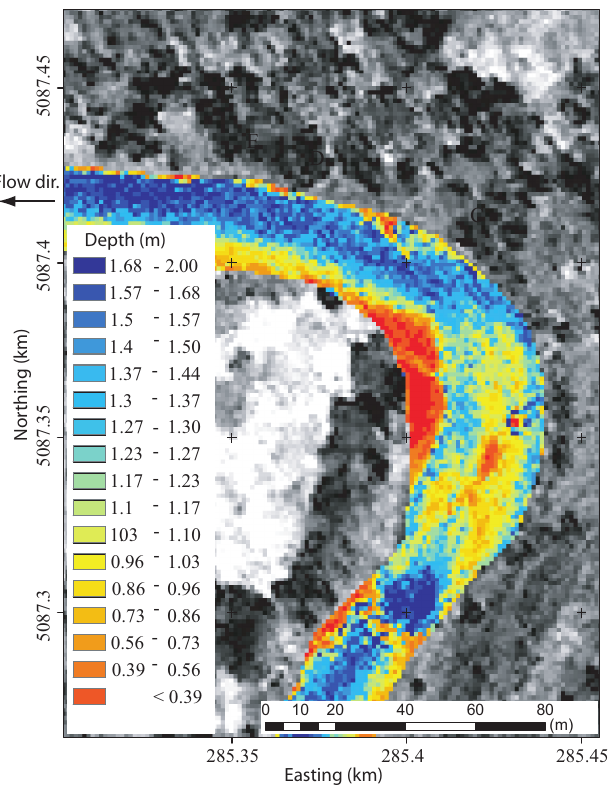
Figure 7. Variation of underwater depth in a 120 ◦ bend.